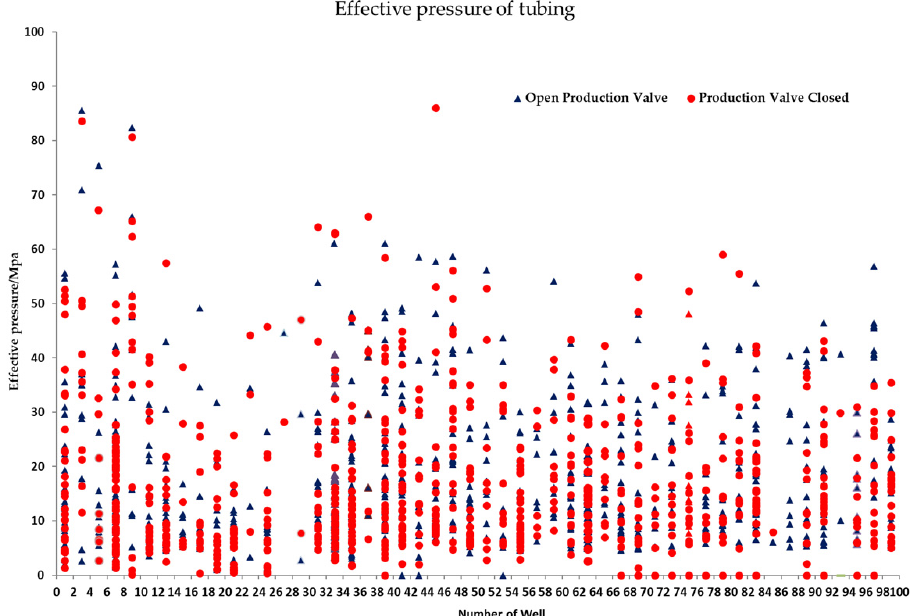
Figure 16. Fluctuation of Annular Pressure on 52 Wells in One Oil Field.